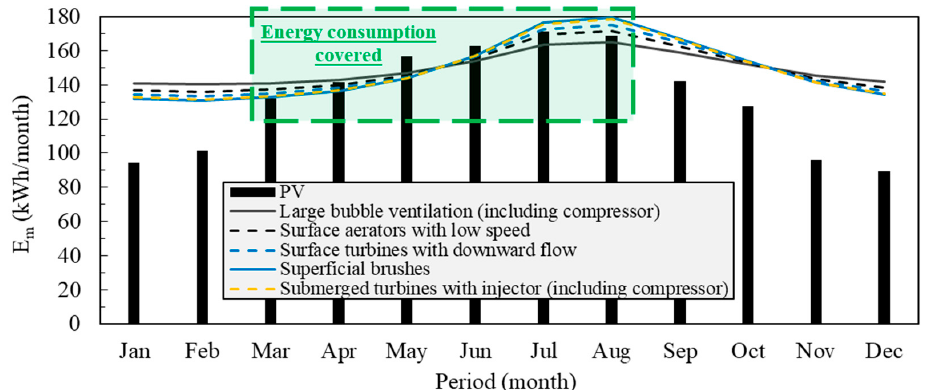
Figure 6. PV energy E m and Ip RO2 in WWTP for each aeration system.